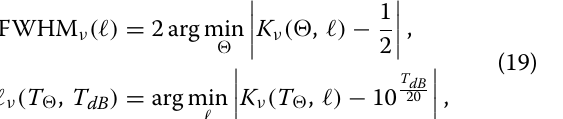
. Dashed lines show RBFs with